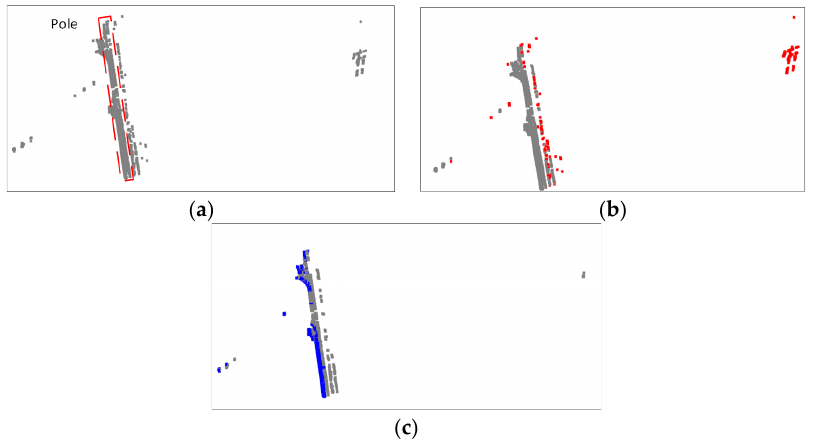
Figure 11. Point cloud preprocessing. ( a ) The frustum generated by the mask and depth map, where the pole points are in the red dot line box; ( b ) The illustration of the noise filter processing. In this case, the red points are noise; ( c ) Adding color (blue) from viewpoint direction.